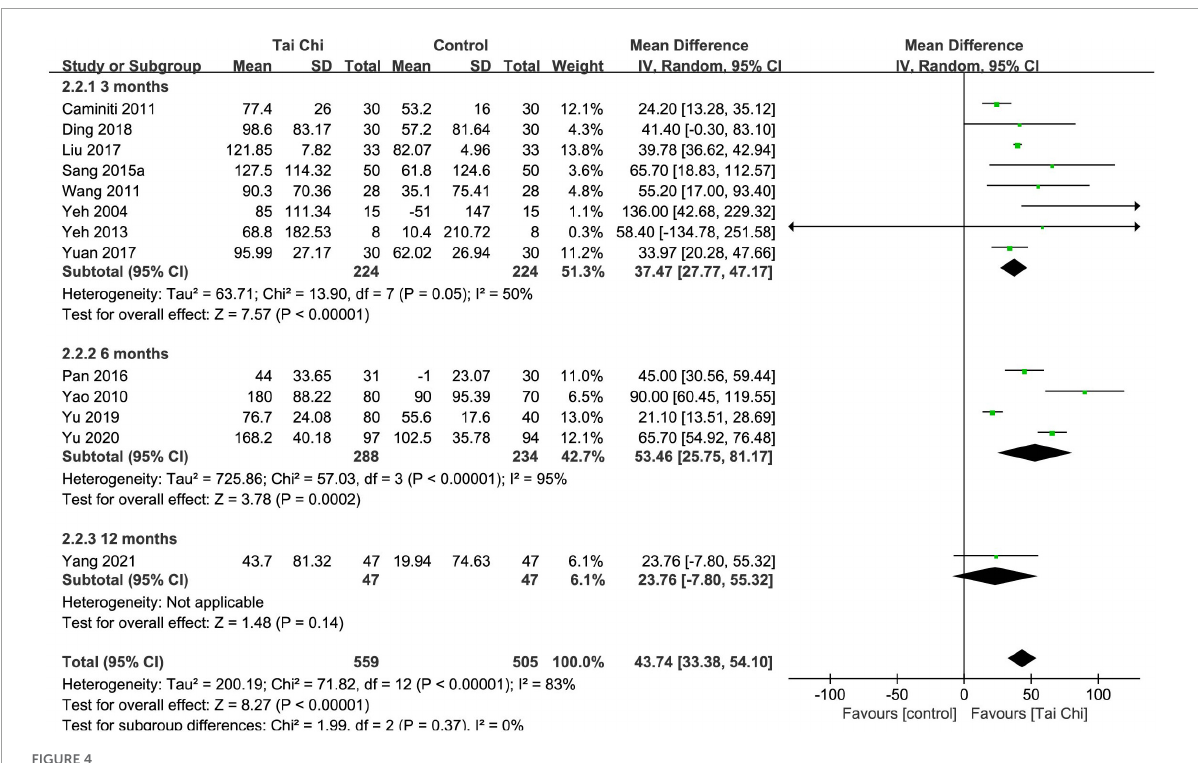
FIGURE4 Meta-analysis of 6MWT in the Tai Chi group vs. the control group. CI, confidence interval; IV, inverse variance; SD, standard